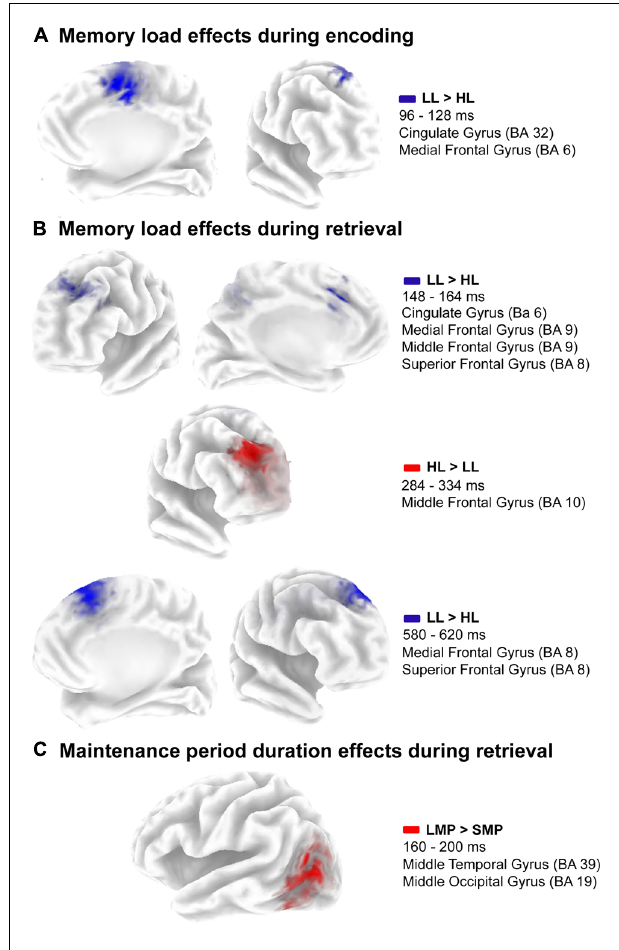
FIGURE 4 | Source location of estimated activation differences. (A) Cluster of voxels where the maximal difference between low load condition and high load condition is located during codification. (B) Cluster of voxels where the maximal difference between low load and high load condition is located during retrieval. (C) Cluster of voxels where the maximal difference between short maintenance period duration and long maintenance period duration is located during retrieval.